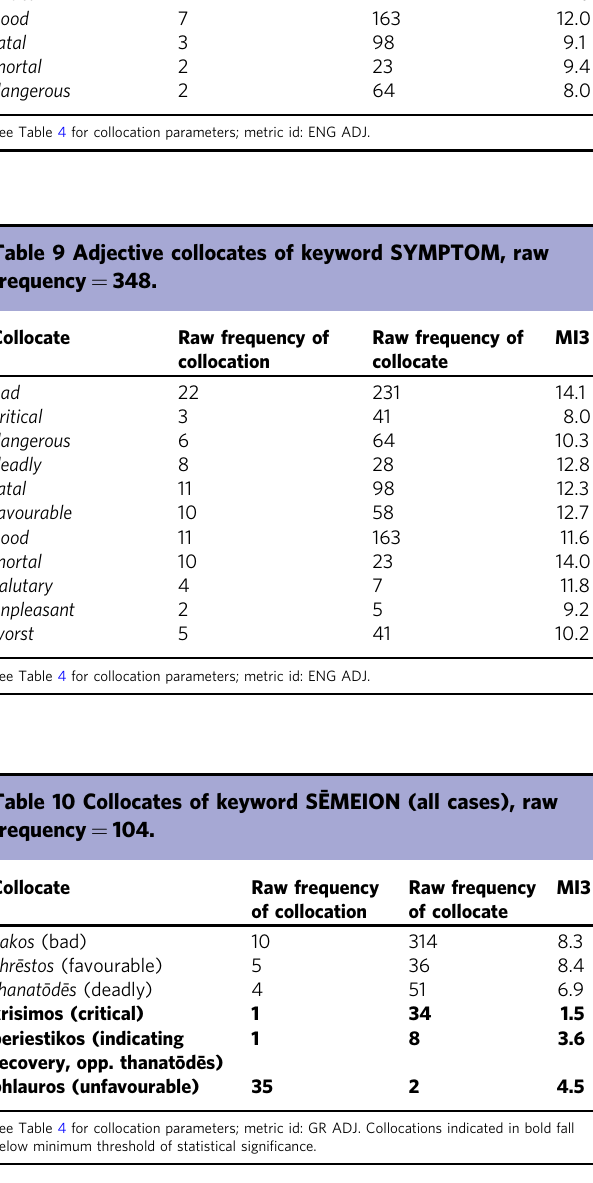
See Table 4 for collocation parameters; metric id: ENG ADJ.